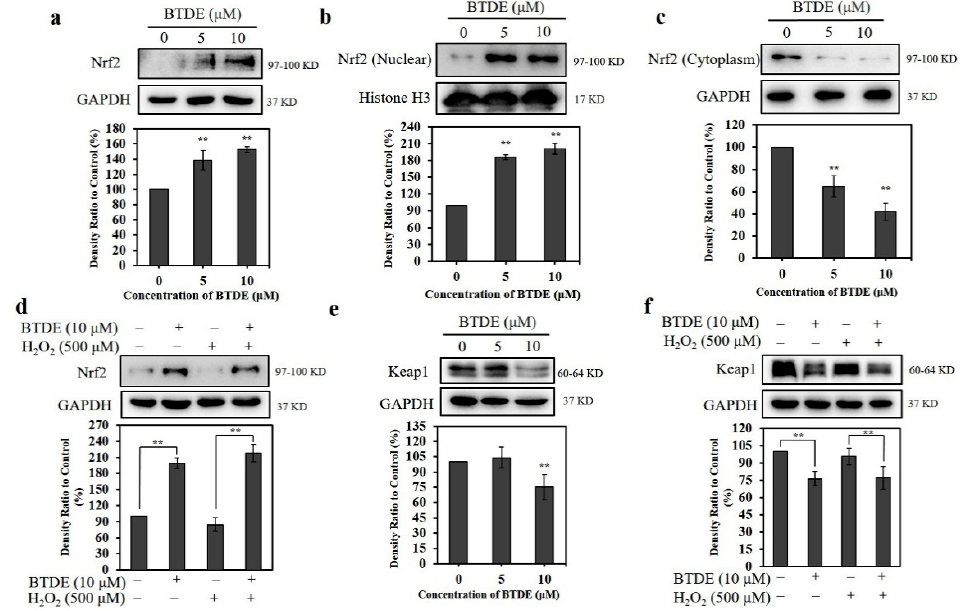
Figure 5. BTDE promotes the nuclear translocation of Nrf2 and decreases the expression of Keap1. ( a ) HaCaT cells were treated with BTDE (5–10 μ M) for 24 h. The expression level of Nrf2 was detected by Western blotting assay. ( b ) HaCaT cells were treated with BTDE (5–10 μ M) for 24 h. The nuclear expression level of Nrf2 was detected by Western blotting assay. ( c ) HaCaT cells were treated with BTDE (5–10 μ M) for 24 h. The expression level of Nrf2 in cytoplasm was detected by Western blotting assay. ( d ) HaCaT cells were pretreated with BTDE (5–10 μ M) for 24 h, and then incubated with or without H 2 O 2 (500 μ M) for 3 h. The expression level of Nrf2 was detected by Western blotting assay. ( e ) HaCaT cells were treated with BTDE (5–10 μ M) for 24 h. The expression level of Keap1 was detected by Western blotting assay. ( f ) HaCaT cells were pretreated with BTDE (5–10 μ M) for 24 h, and then incubated with or without H 2 O 2 (500 μ M) for 3 h. The expression level of Nrf2 was detected by Western blotting assay. Values are expressed as the mean ± SD of three independent experiments. ** p < 0.01, versus control group.